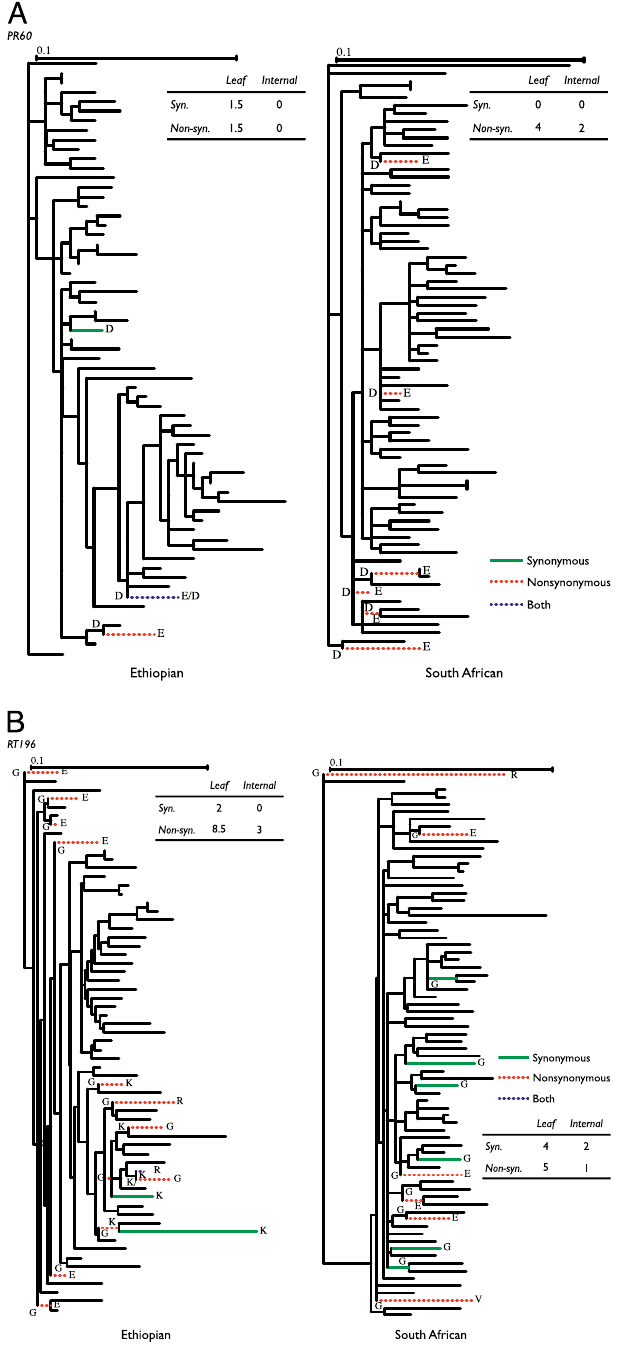
Figure 3. Inferred Evolutionary History at Two Codons in pol (A) Codon 60 in protease. The trees were rooted using subtype B reference sequences from the Los Alamos HIV database, and ancestral states were inferred using maximum likelihood under the MG94 3 012232 Dual GDD 3 3 3 [40] model of codon evolution. (B) Codon 196 in RT.